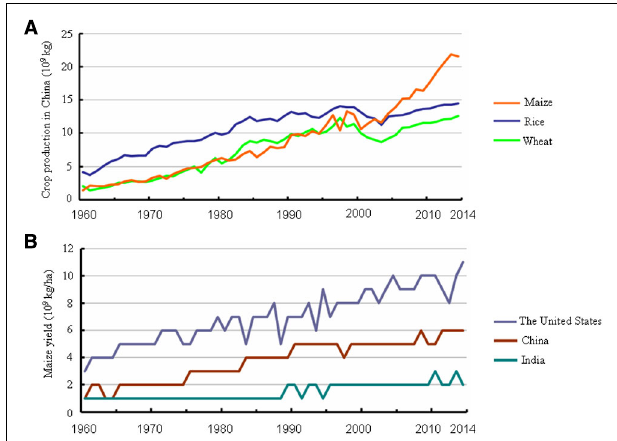
FIGURE 1 | Changes in maize yield from 1960 to 2014 in China, India, and the United States. (A) Average annual production of maize, rice, and wheat in China. (B) Comparison of maize yield per unit area among China, India, and the United States. Data were retrieved at: